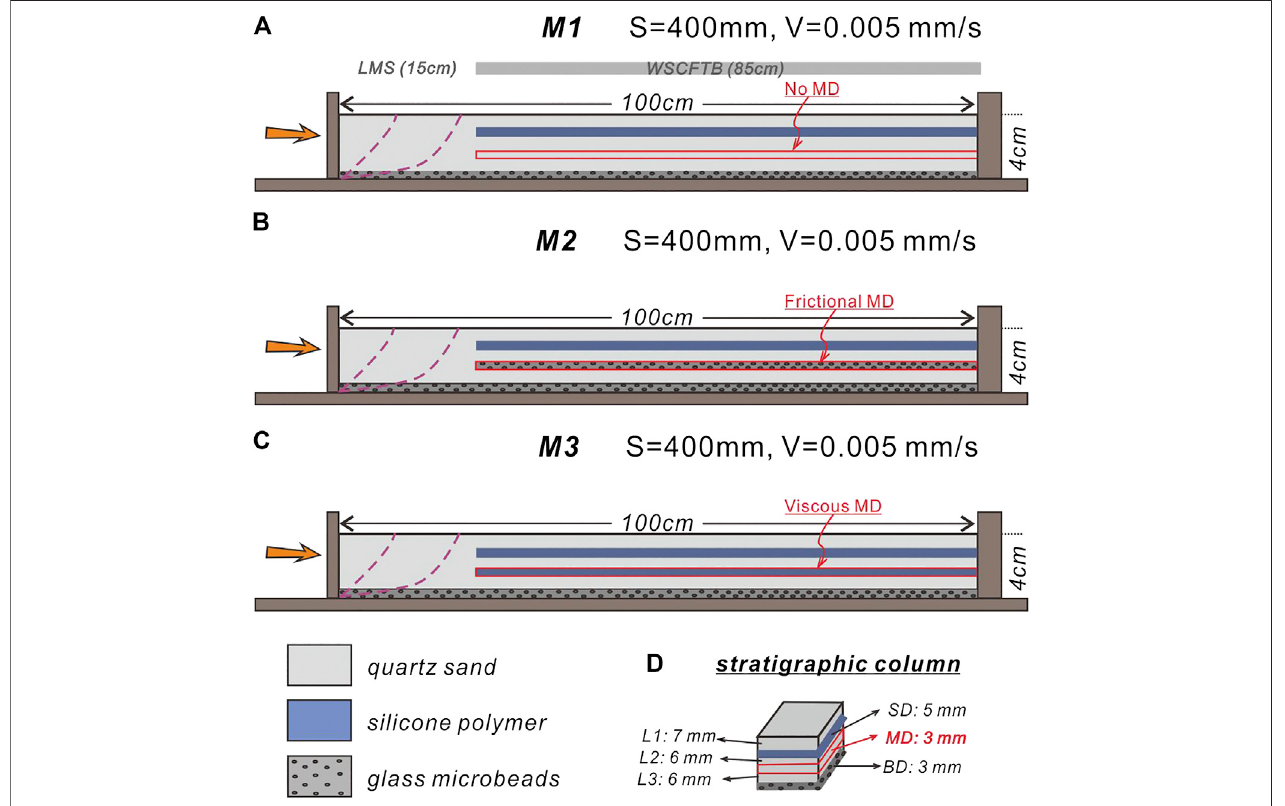
FIGURE4| Experimentaldesigns.Thelayersoutlinedbyredareourinvestigatedmid-leveldecollements.Alltheotherboundaryconditionsareidenticalinthethree experiments. SD: shallow décollement; MD: mid-level décollement; BD: basal décollement.